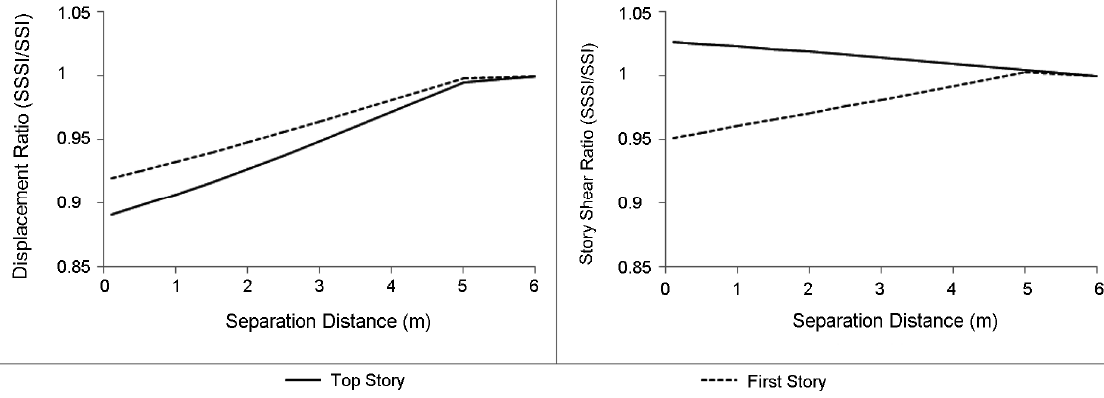
Fig. 5. Effect of separation distance between twin buildings